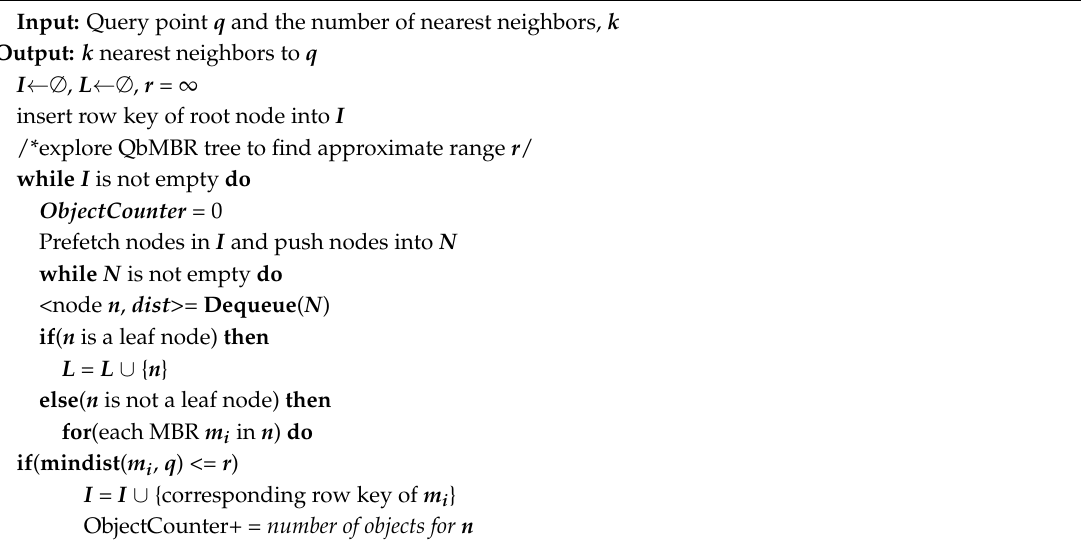
Algorithm 4. kNN query